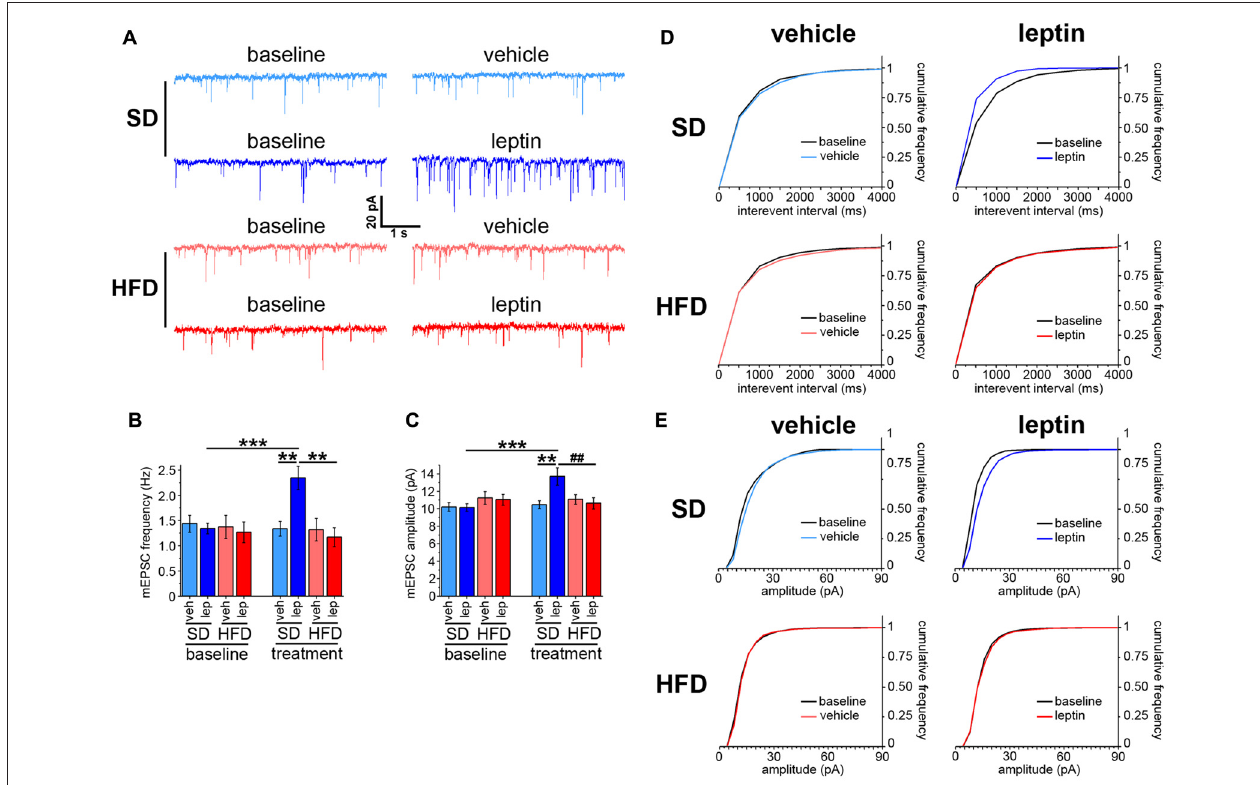
FIGURE 1 | Leptin modulates spontaneous neurotransmitter release in standard diet (SD), but not in high-fat diet (HFD), mice. (A) Representative traces showing miniature excitatory postsynaptic current (mEPSC) recordings in SD and HFD mice treated with vehicle or leptin; both baseline and post-treatment (i.e., vehicle or leptin) recordings, corresponding to the same cell, are shown. (B) mEPSC frequency is increased in SD mice in response to leptin application; in contrast, HFD mice are resistant to this effect (SD-veh n = 13, SD-lep n = 11, HFD-veh n = 11, HFD-lep n = 14; analysis of variance (ANOVA)-2 diet × treatment interaction p =